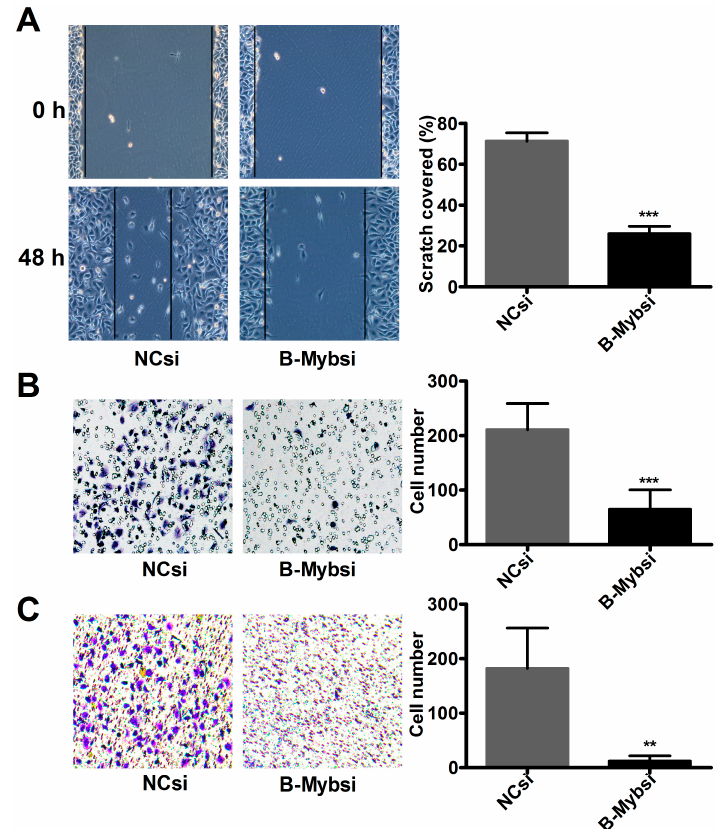
Figure 5. B-Myb knockdown decreases cell migration and invasion. B-Myb knockdown inhibits cell migration. H1299 cells were transiently transfected with negative control siRNA and siRNA against B-Myb, and then subjected to (A) a wound healing assay, (B) a Transwell migration assay, and (C) a Transwell invasion assay, as described in the Materials and Methods section, respectively. ** p < 0.01, *** p <